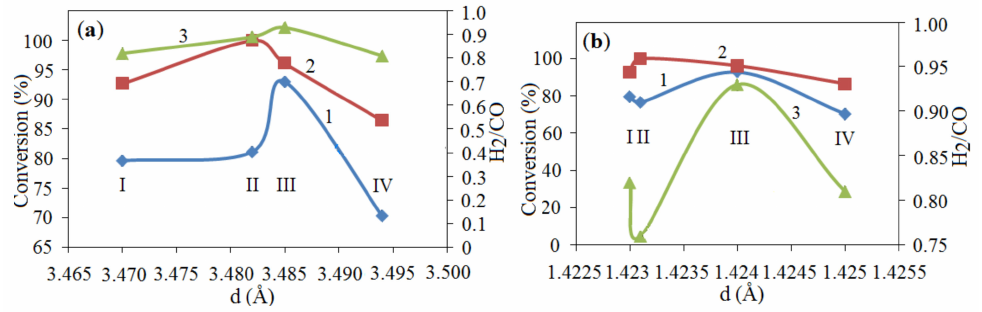
Figure 15. Effect of structural deformation and the composition of catalysts on CH 4 and CO 2 conversion and on the H 2 /CO ratio: ( a ) Al 2 O 3 : I—24.1% NiO, II—25.8% NiO, III—29.2% NiO, IV—34.4% NiO; ( b ) NiAl 2 O 4 : I—24.1% NiO, II—27.5% NiO, III—29.2% NiO, IV—34.4% NiO.